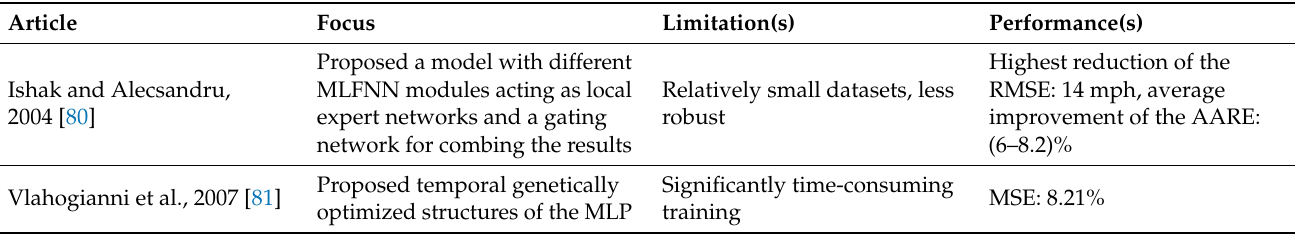
Table 12. Summary of the works found using MNNs.